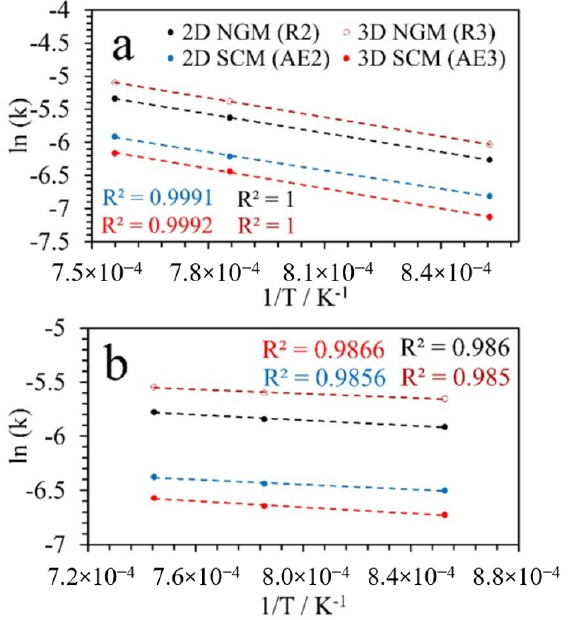
Figure 8. Arrhenius plots for ( a ) CH 4 -induced reduction and ( b ) CO 2 -induced re-oxidation over CeO 2 oxygen carrier performed in solar thermogravimetric reactor using concentrated solar ener- gy.